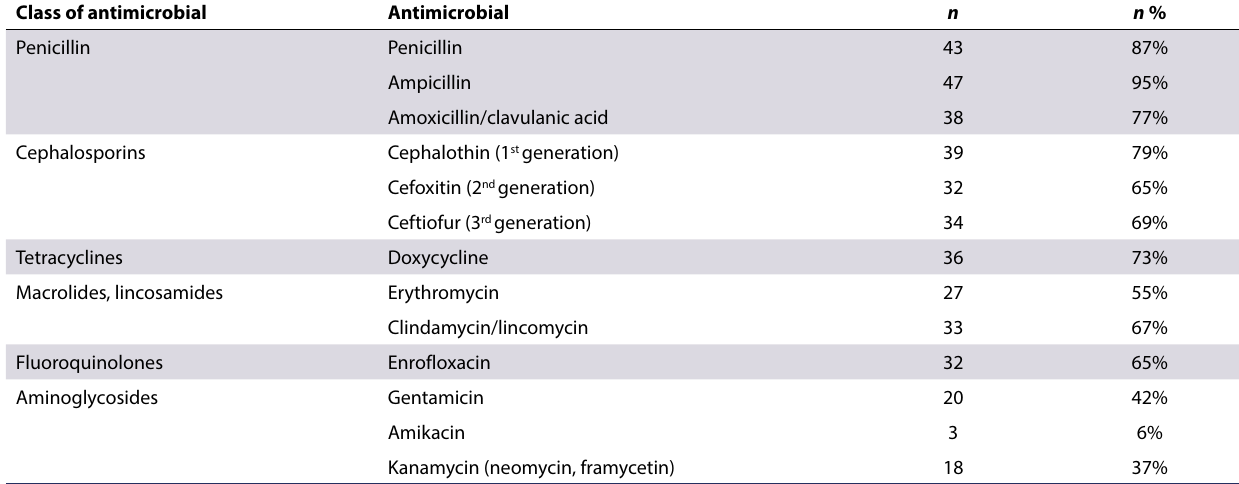
Table II: Antimicrobial resistance profile in Staphylococcus pseudintermedius amongst mec A positive clinical isolates ( n = 49) Class of antimicrobial Antimicrobial Penicillin